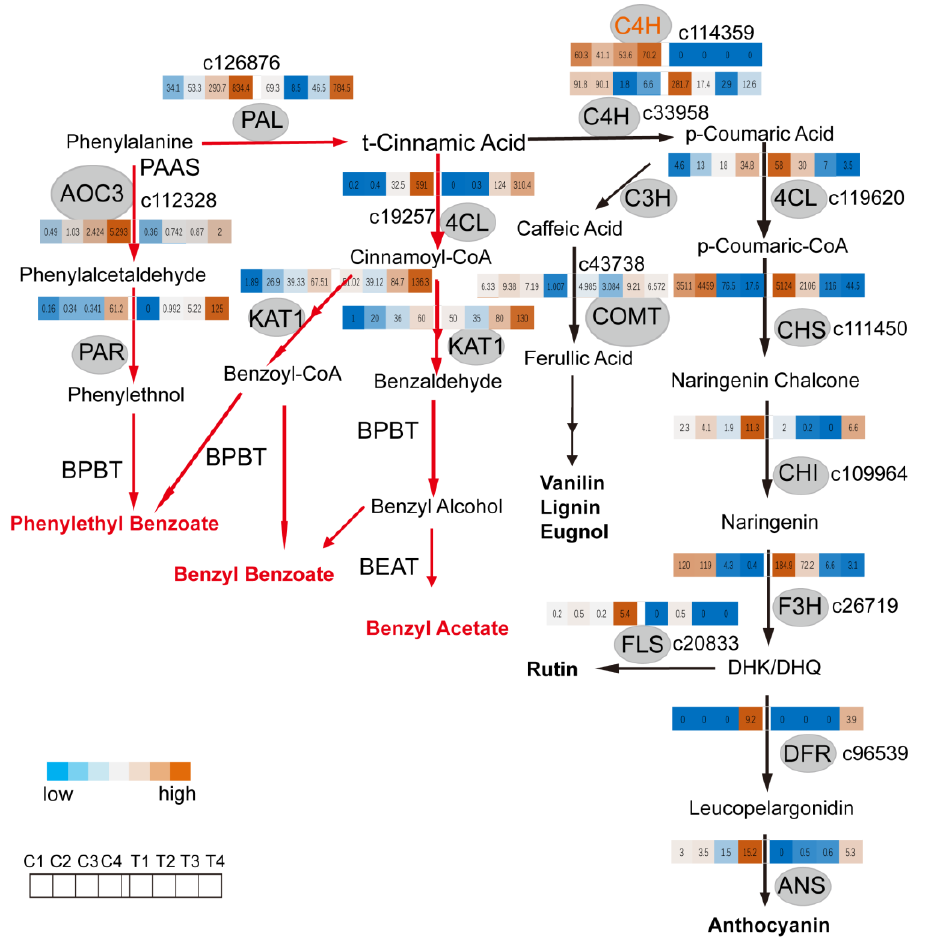
Figure 4. Expression patterns of DEGs related to branches of the phenylpropanoid pathway in tepals and coronas of Narcissus during flower development. Branches of the phenylpropanoid pathway in Narcissus and expression patterns analysis of DEGs, are related to flavonoids metabolic pathway and benzenoid/phenylpropanoid metabolic pathway. The red line and arrowhead in the left panel represent the phenylpropanoid biosynthesis pathway, and the black line and arrowhead represent the flavonoid/anthocyanin biosynthesis pathway. The heat map shows the expression patterns of differentially expressed structural genes related to branches of the phenylpropanoid pathway in the tepals and coronas at different periods (left down). Each row means one unigene and the expression changes of unigenes are shown by color grids based on FPKM value (fragments per kilobase of exon per million reads mapped). The color bar from blue to orange shows upregulated; from orange to blue is downregulated. Enzyme names are shown in the gray background circle. 4CL, 4-coumarate CoA ligase; KAT, 3-ketoacyl-CoA thiolase; C4H, cinnamic acid 4-hydroxylase; AOC3, amine oxidase, copper containing 3; PAR, phenylacetaldehyde reductase; BEAT, acetyl-CoA: benzylalcohol acetyltransferase; BPBT,